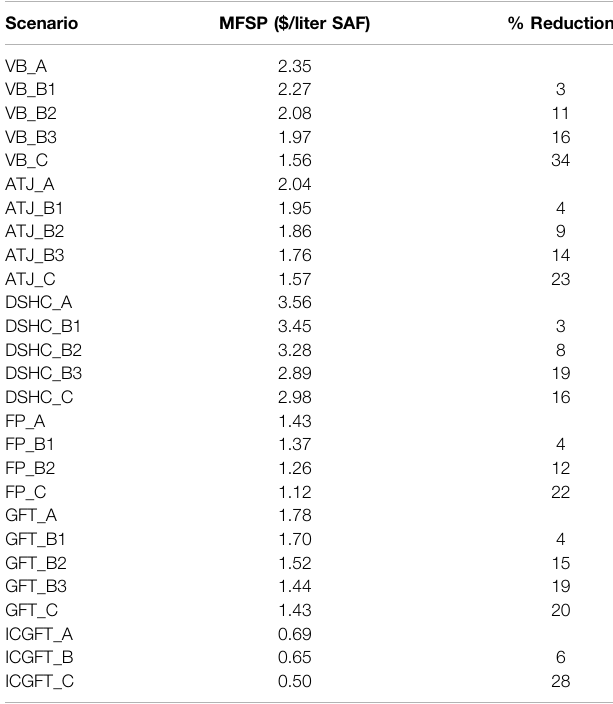
TABLE 5 | MFSPs of all studied